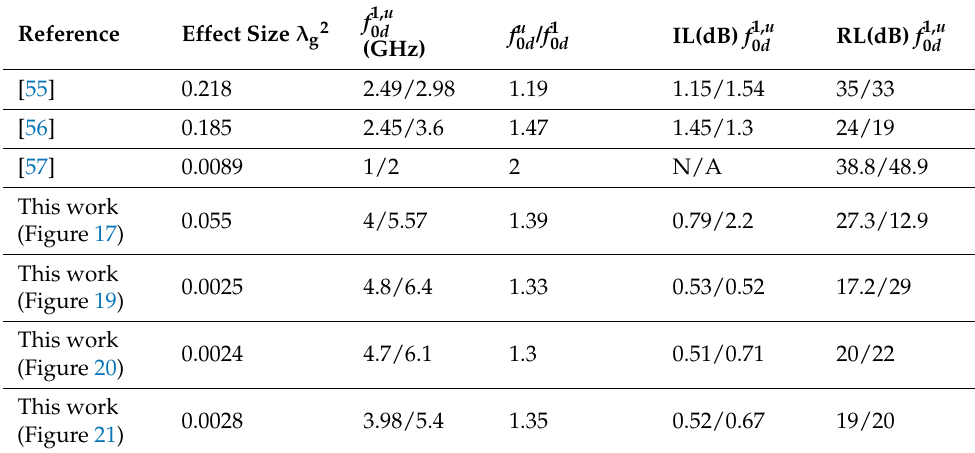
Table 4. Comparison between different models of